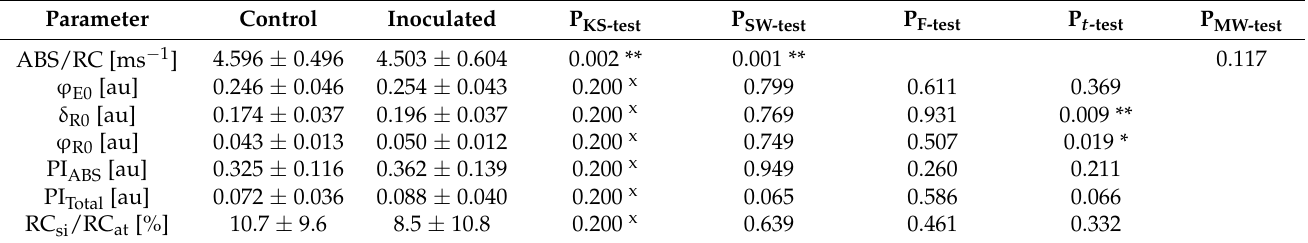
Values represent means ± standard deviation. * indicates a significance p < 0.05, ** a significance p < 0.01, x that this is a lower bound of the true significance, KS: Kolmogorov–Smirnov, SW: Shapiro–Wilk, MW: Mann–Whitney U [au—arbitrary